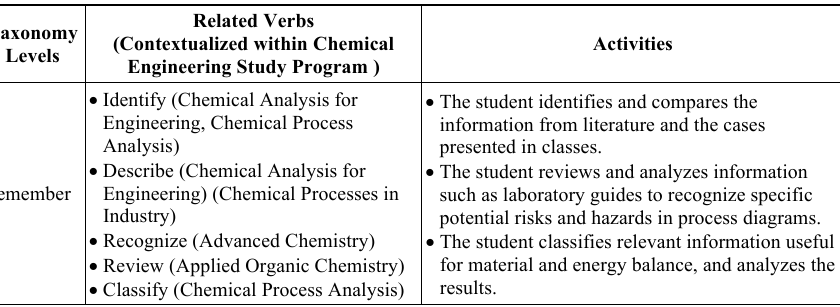
Table 3. Bloom’s taxonomy verbs and